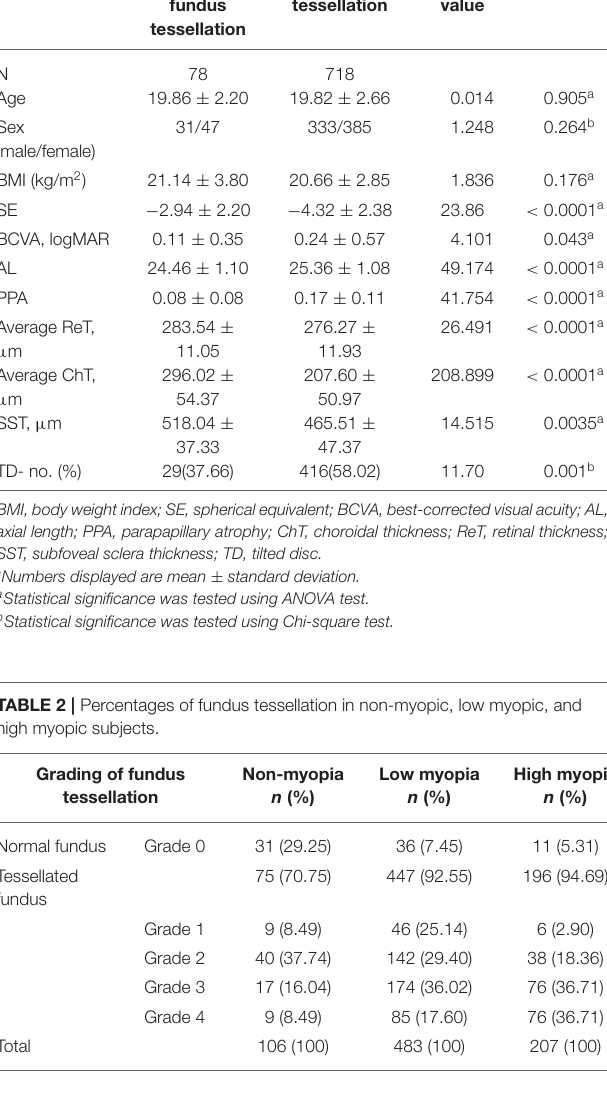
TABLE 1 | Comparison of characteristics between participants with or without fundus tessellation * . Variable Without